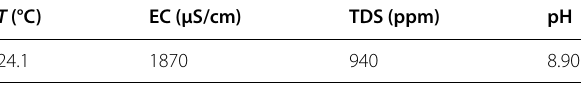
Table 1 The measurable parameters for inflow used water